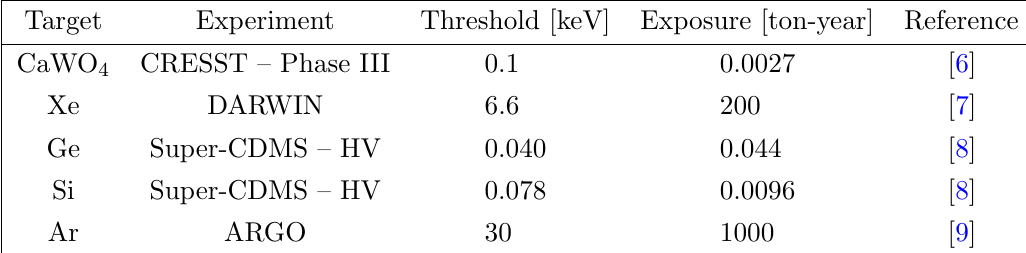
Table 1 . Proposed direct detection experiments considered in this